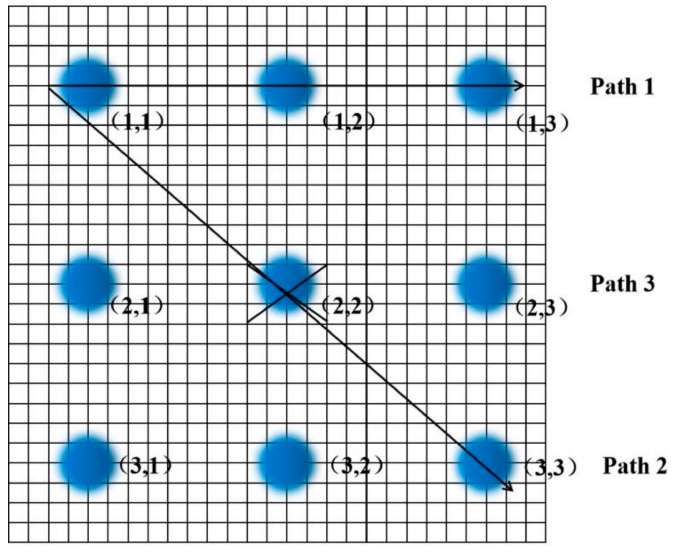
Figure 11. Target movement path equivalence diagram.